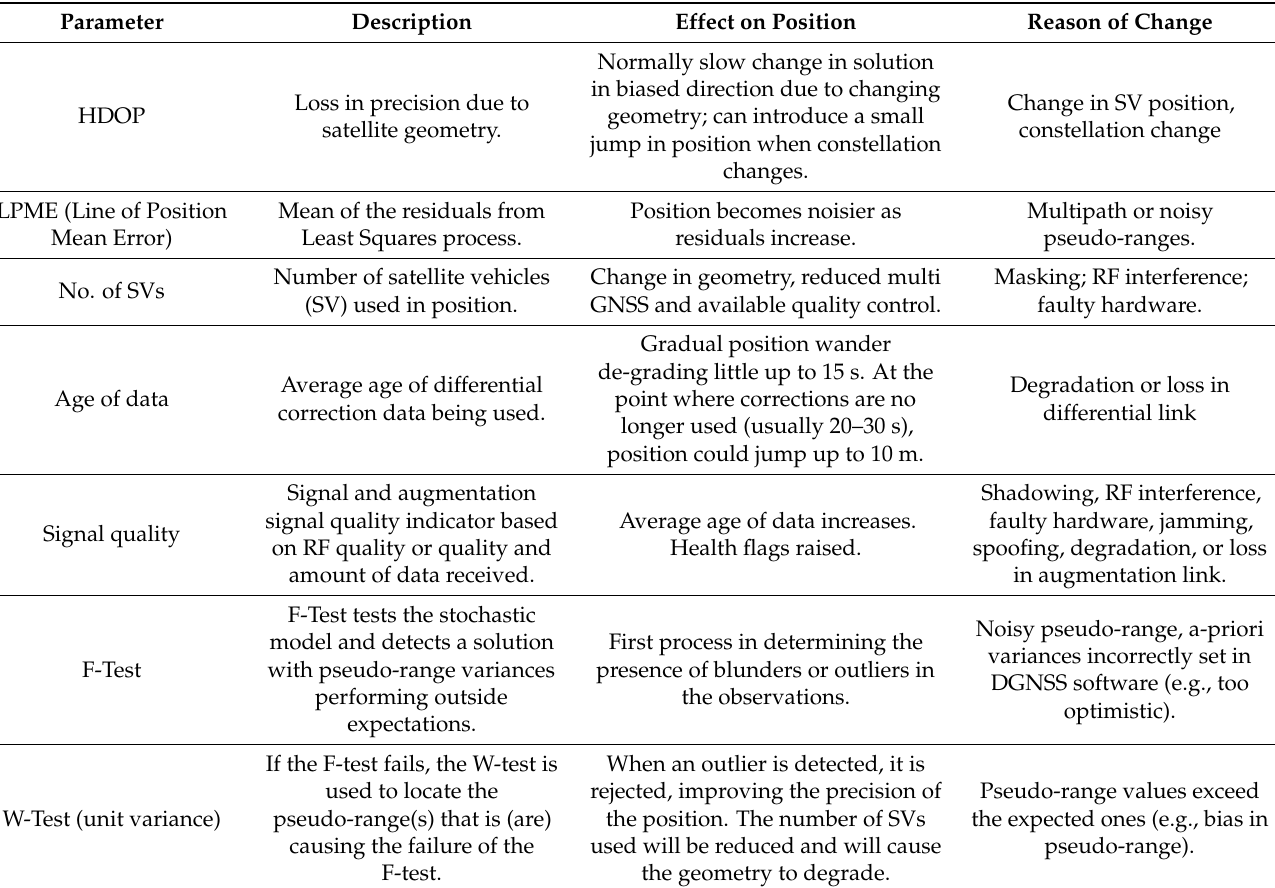
Table 7. GNSS quality indicators as proposed by IMCA (based on